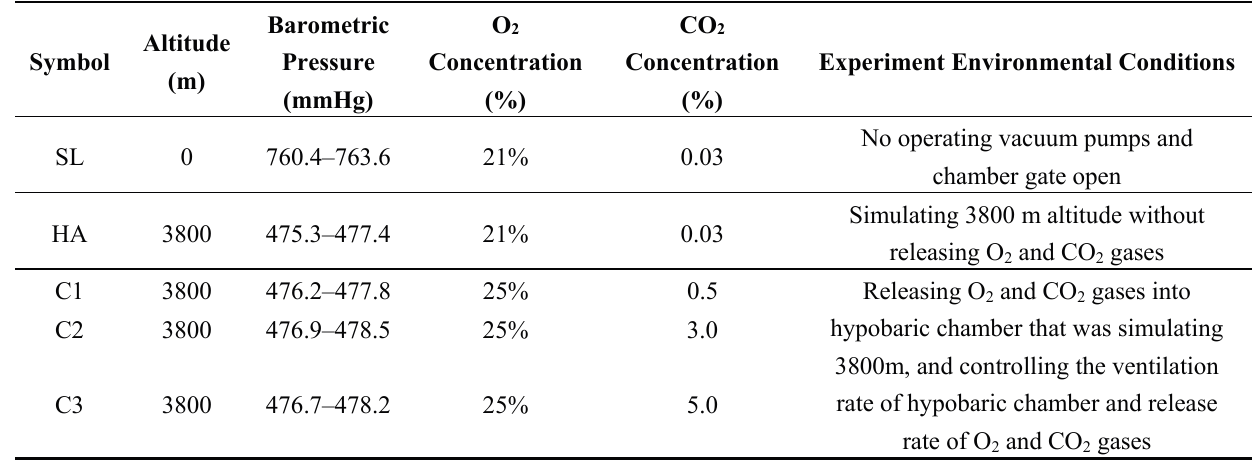
Table 2. Characteristics of the experimental conditions.